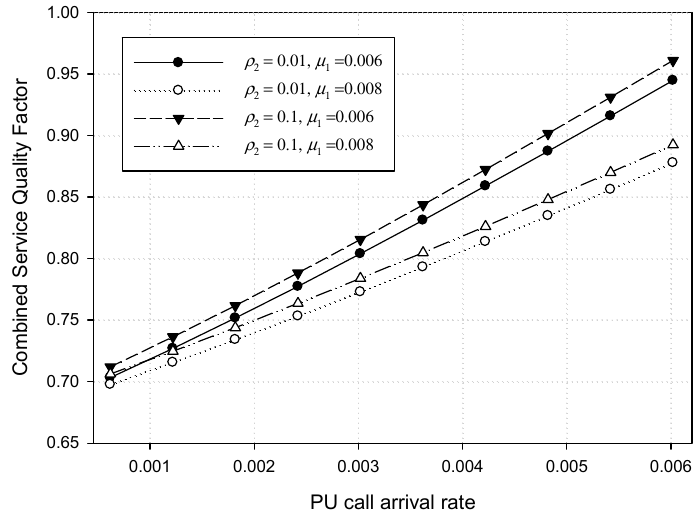
Figure 9. Combined service quality factor for both PU and CU calls.